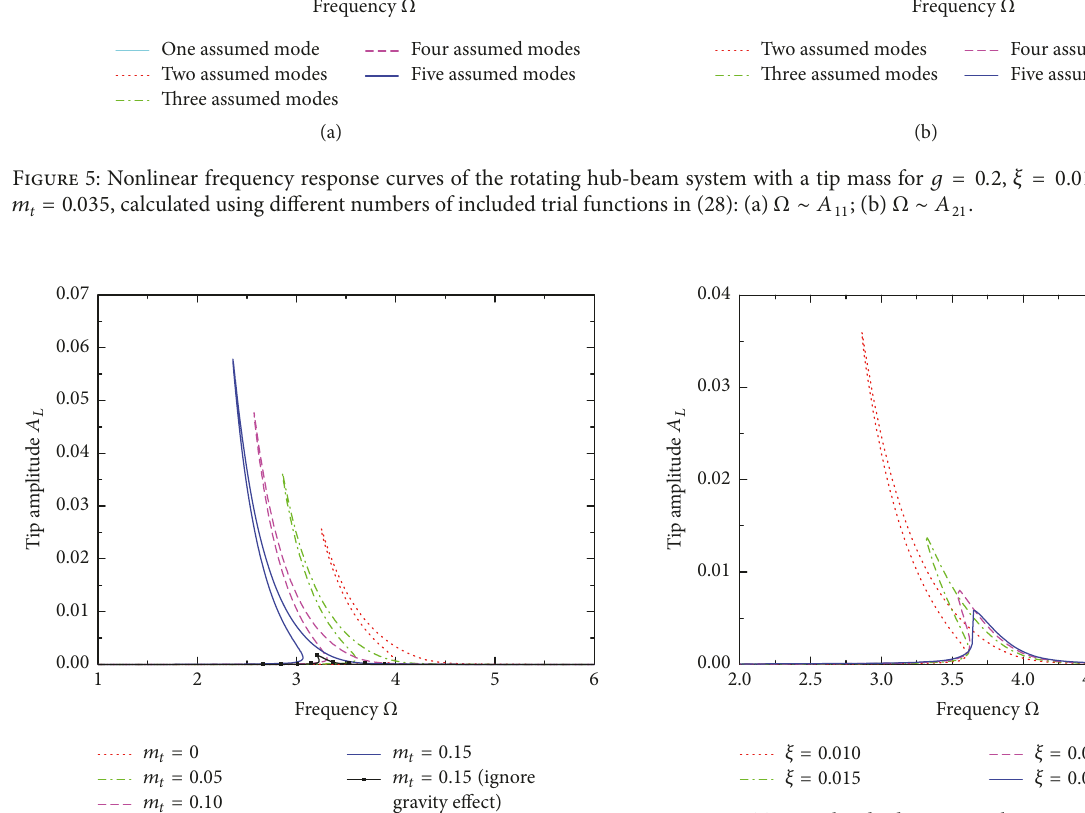
Figure 7: Tip amplitude diagram with respect to the variation in damping ratio 𝜉 for 𝑔 = 0.2 , 𝑚 𝑡 = 0.05 , 𝑟 0 = 0.0909 , and 𝑛 = 5